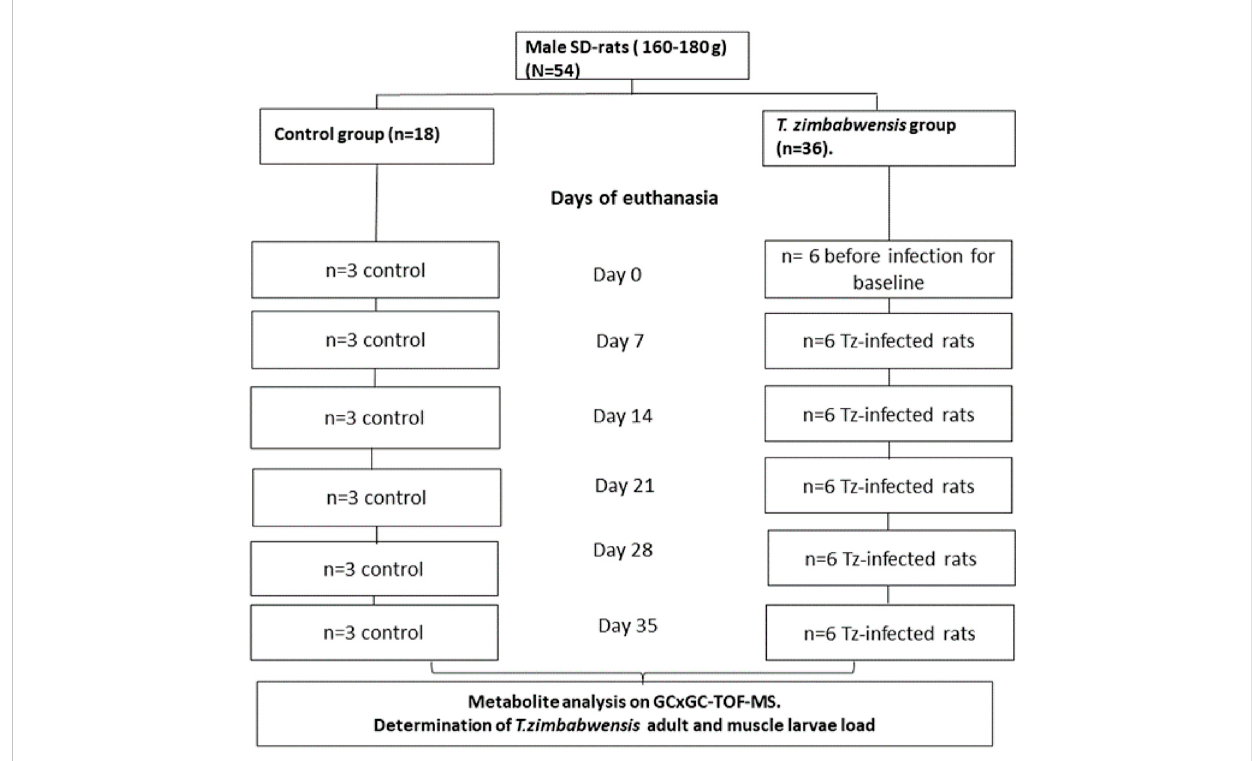
FIGURE 1 Schematic diagram of the experimental design. SD = Sprague-Dawley; T. zimbabwensis = Trichinella zimbabwensis, T.z -infected = Trichinella zimbabwensis